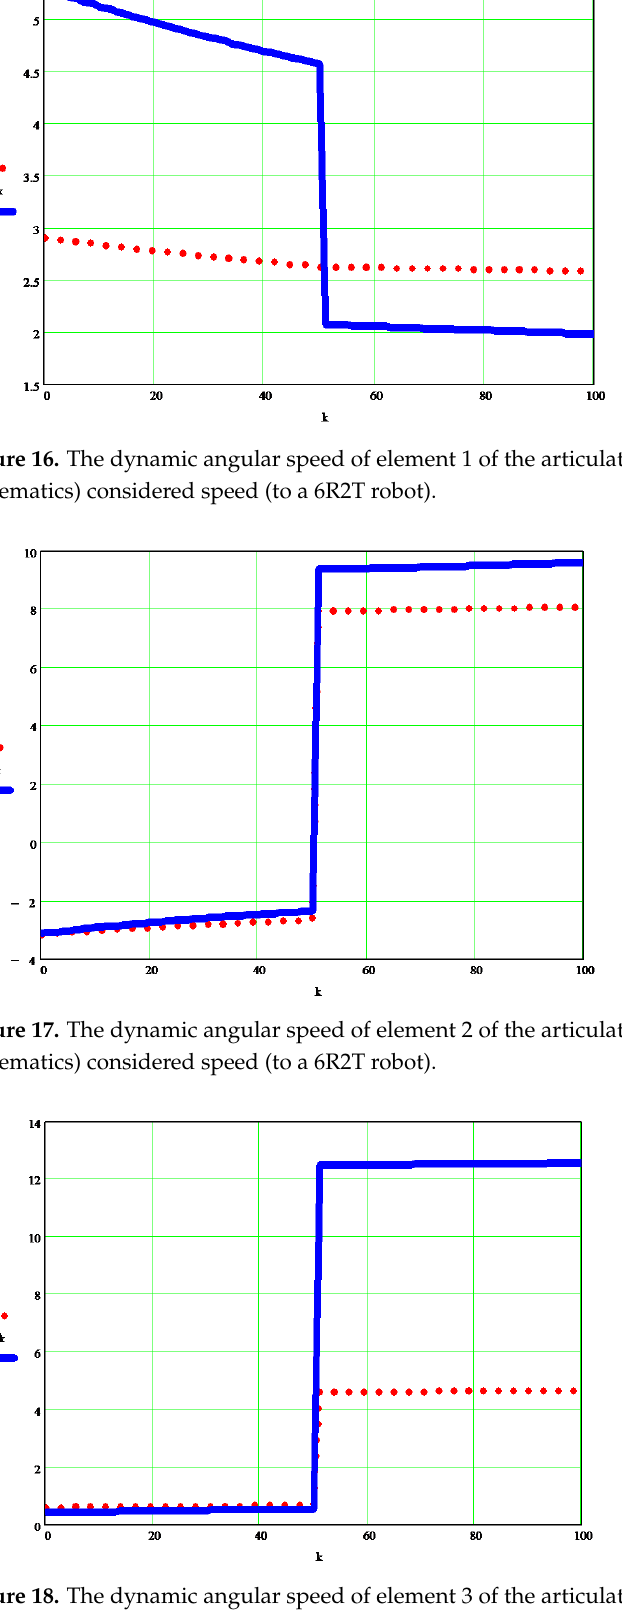
Figure 19. The dynamic angular speed of element 4 of the articulated robot, compared to the input (kinematics) considered speed (to a 6R2T robot).